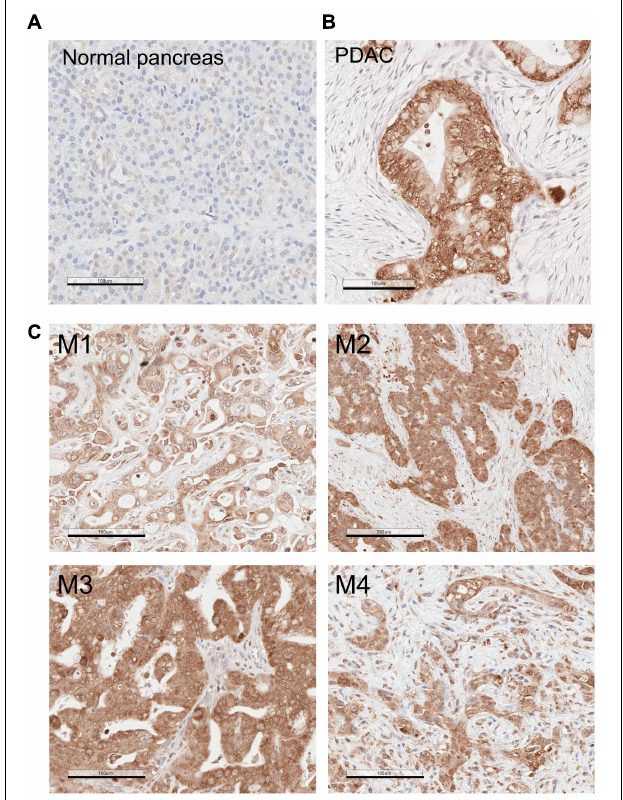
FIGURE 1 | MSP expression is upregulated in Pancreatic ductal adenocarcinoma (PDAC) primary tumors and liver metastasis. Immunohistochemistry (IHC) analysis of human tissues using anti-MSP antibody. (A) Normal pancreas; (B) PDAC; (C) Pancreatic cancer metastasis to the liver. Magnification: 20 × ; Scale bar: 100 µ m.